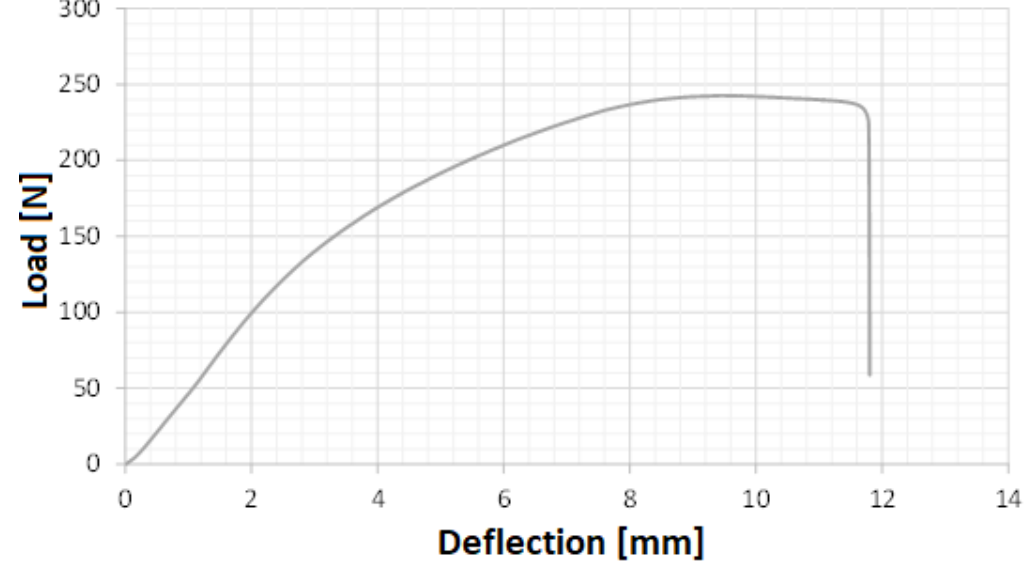
Figure 11. Load vs. mid-span deflection measured during sample c3 testing.